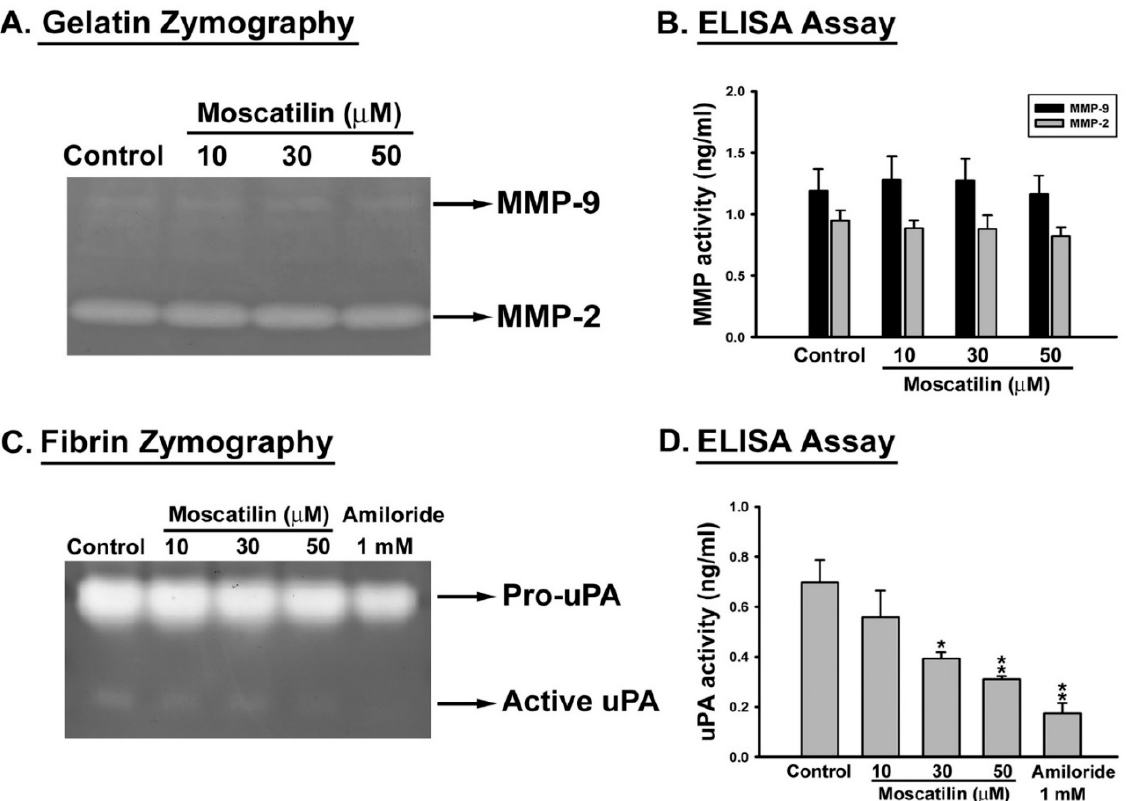
Figure 2. Effect of moscatilin on the enzyme activity of MMP and uPA in human HCC cells. SK-Hep-1 cells were treated without or with the indicated concentration of moscatilin or amiloride (1 mM) in medium containing 10% FBS. After 12 h of treatment, each conditioned medium was collected for analysis of proteolytic activities of MMP-2, MMP-9 and urokinase plasminogen activator (uPA) by zymography ( A , C ) and ELISA assay ( B , D ), respectively. Data are expressed as mean ± S.E.M. of four independent experiments. * p < 0.05, and ** p < 0.01 compared with the control group.